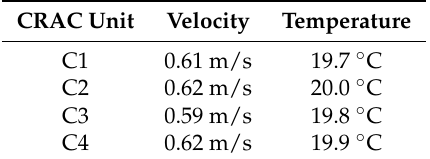
Table 1. Boundary conditions for the CRAC